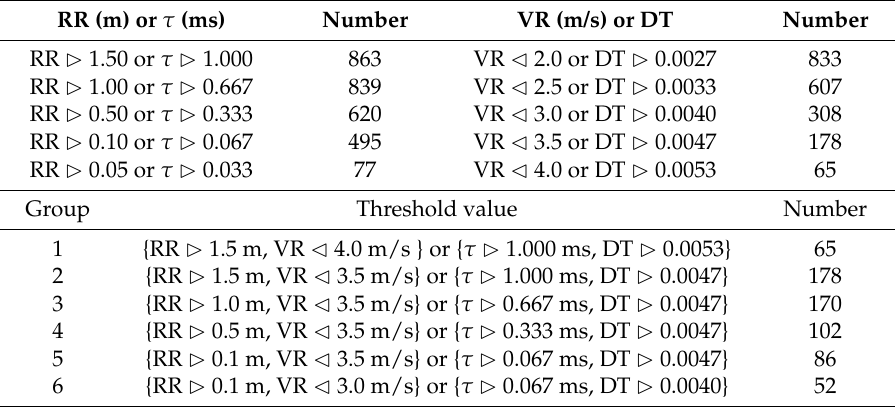
Table 2. The number of call pulses under different RR and DT (or VR) threshold